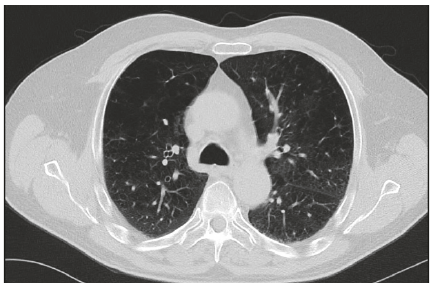
Figure 4: Repeat Chest CT, after one week of the initial CT, showing almost complete resolution of previous infiltrates, disappearance of mediastinal lymphadenopathy, and resolution of bilateral pleural